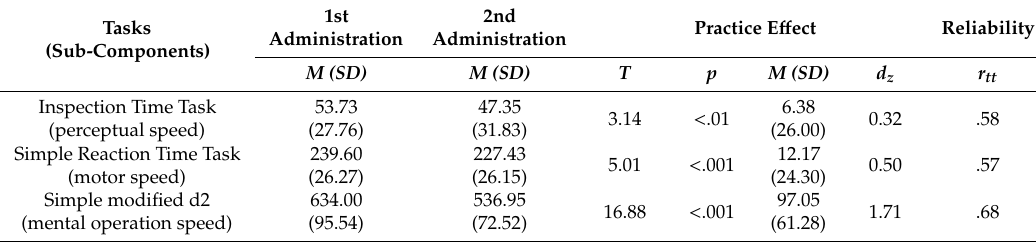
Table 1. Mean reaction times / inspection time (in ms), standard deviations, retest reliabilities and practice e ff ects (in ms) of the complex modified d2 and the tasks assessing the sub-components of sustained attention test